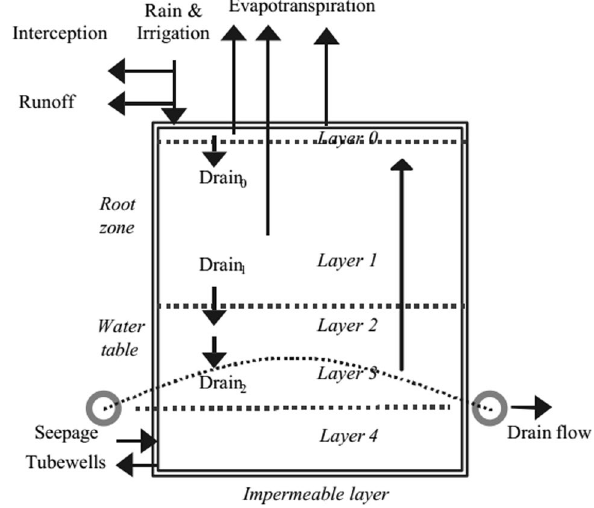
Fig. 1 An overview of the multi soil layer water balance in the WaSim Model (after Hess et al.